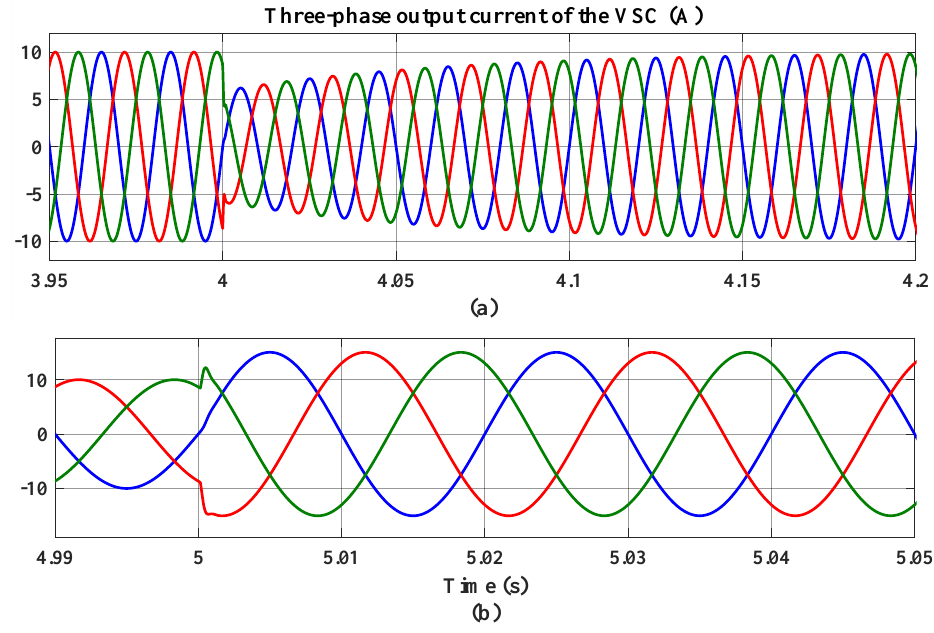
Figure 13. The three-phase output current of the VSC response to the ( a ) 50% voltage sag in grid-side voltage magnitude, and ( b ) step change in current reference from 10 A to 15